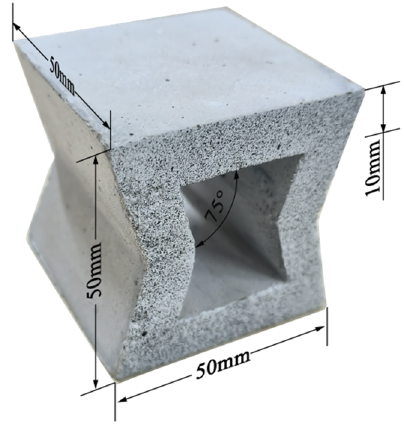
Figure 1. Design of the concave hexagonal unit cell of foam concrete.